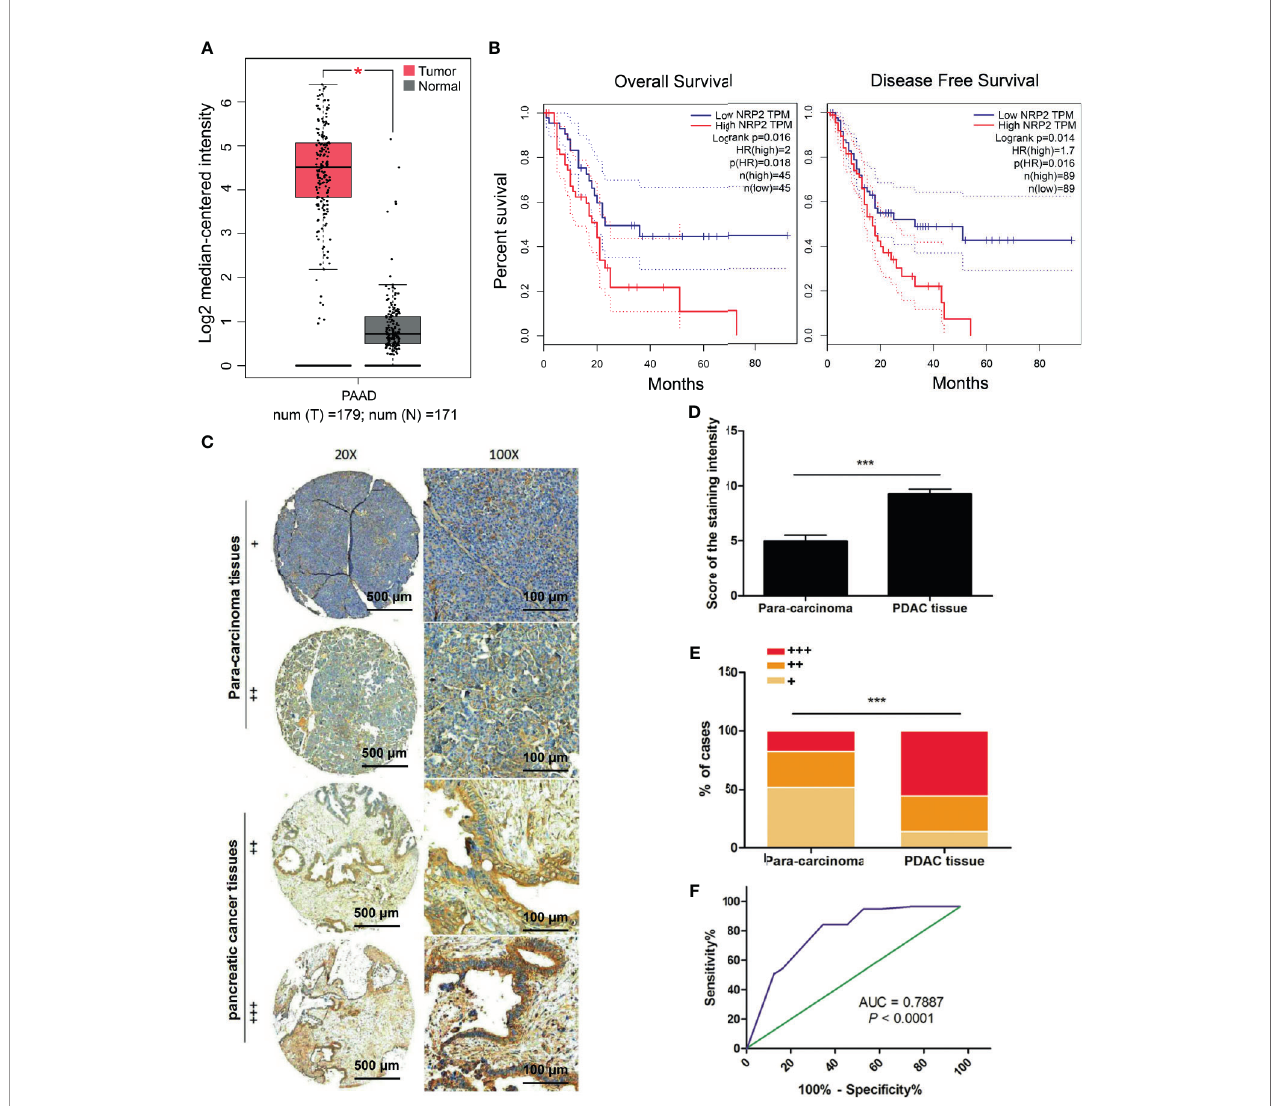
FIGURE 1 | Expression of NRP2 in PDAC. (A) Box plots of the nrp2 gene expression in PDAC and normal pancreatic tissues from the GEPIA database, * P < 0.0001. (B) The correlation between NRP2 expression with Overall Survival (OS, n=45) or Disease-Free Survival (DFS, n=89) from the GEPIA database, P < 0.05. (C) NRP2 protein expression level was analyzed by IHC based on a TMA containing 60 pancreatic cancer specimens. Signi fi cant differences in (D) scores of the staining intensity and (E) proportions of 3 cases (strong, +++; moderate, ++; weak, +) between pancreatic cancer and adjacent para-carcinoma tissues, *** P < 0.0001. (F) ROC (receiver operating characteristic) curve for NRP2 was plotted by sensitivity and speci fi city, AUC = 0.7887, 95% CI = 0.7028 ~ 0.8745, P <